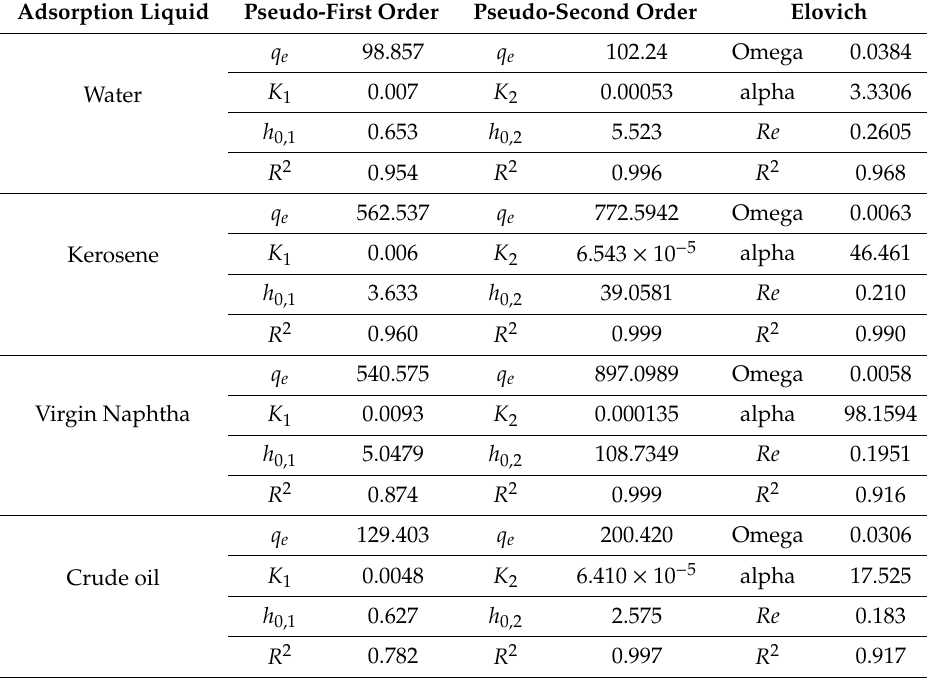
Table 8. The kinetic coe ffi cients of PFO, PSO and and Elovich models for 5-EGF